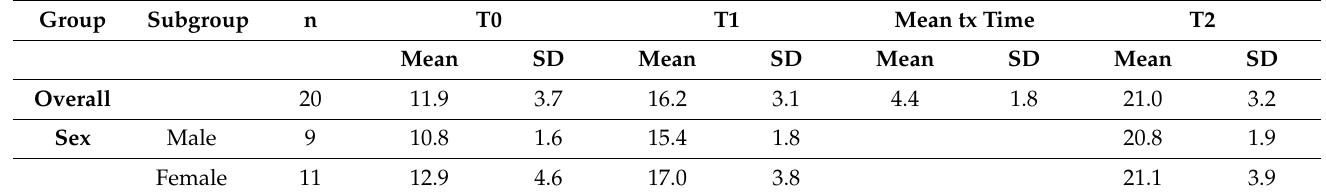
Table 1. Sample sizes and ages (y), at T0 (the start of orthodontic treatment), T1 (the end of orthodontic treatment), and T2 (follow-up) for the overall sample and subgroups.